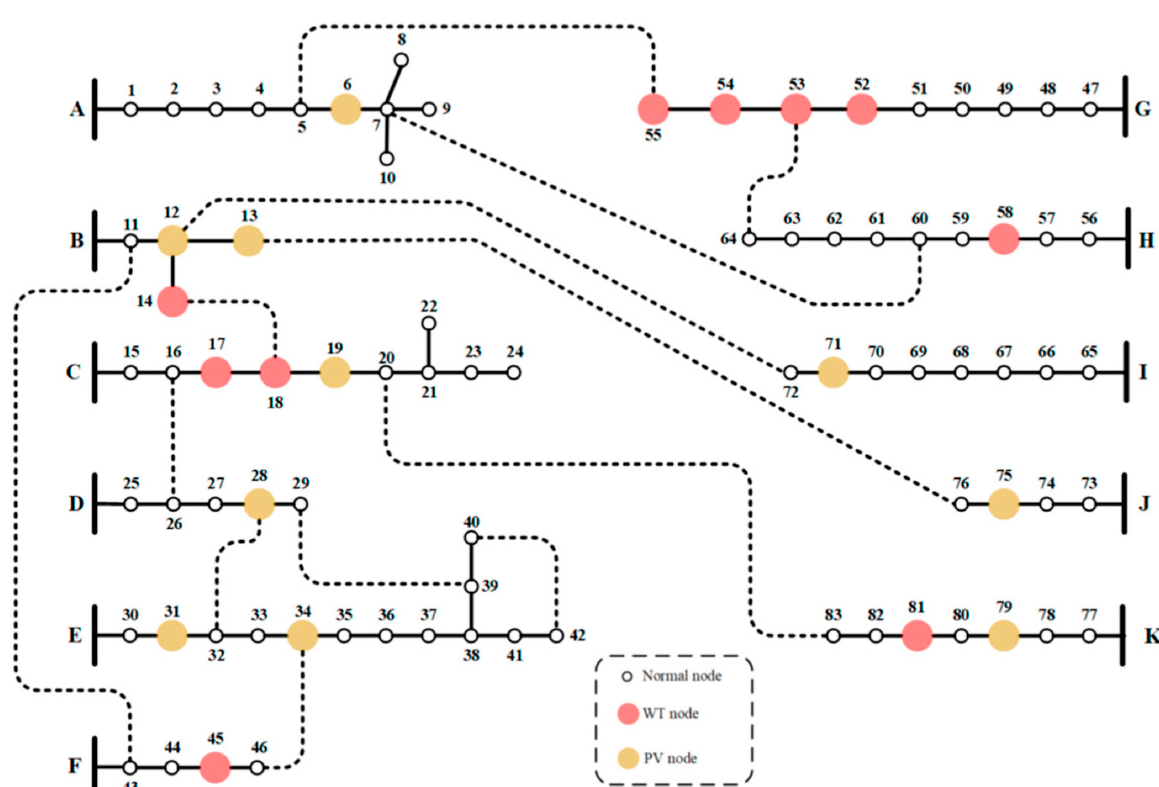
Figure 8. 83-node real distribution network in Taiwan.